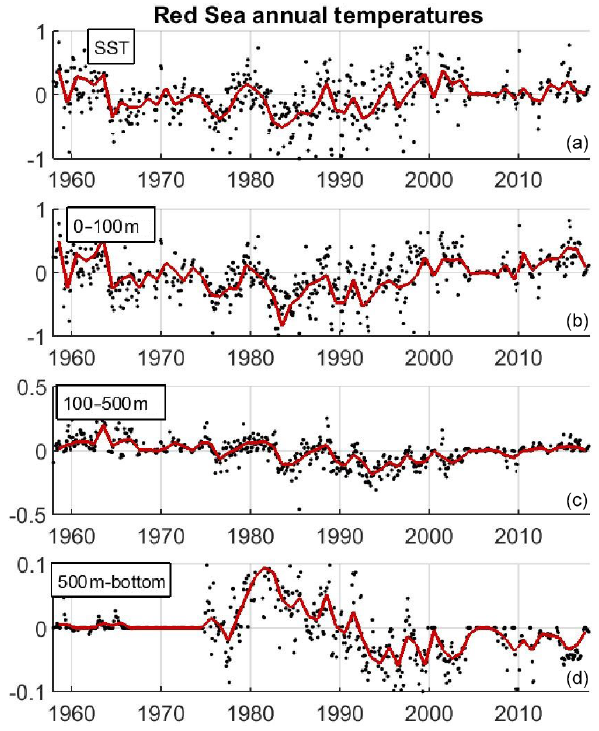
Figure 15. Time series of yearly averaged temperature (in ◦ C) in different layers (a) SST, (b) 0–100m, (c) 100–500m and (d) 500m bottom, in the Red Sea. Black dots indicate the monthly values with formal error below 0.2 ◦ C. Note the different vertical axis in each panel.